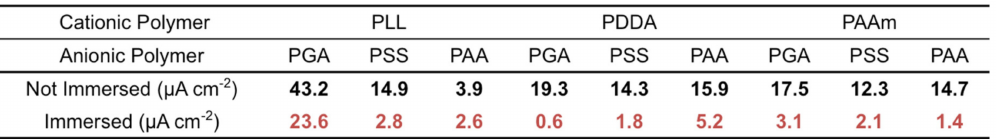
Figure 3. C urrent densities of the glassy carbon electrodes modified with Pp ADH and PIC.